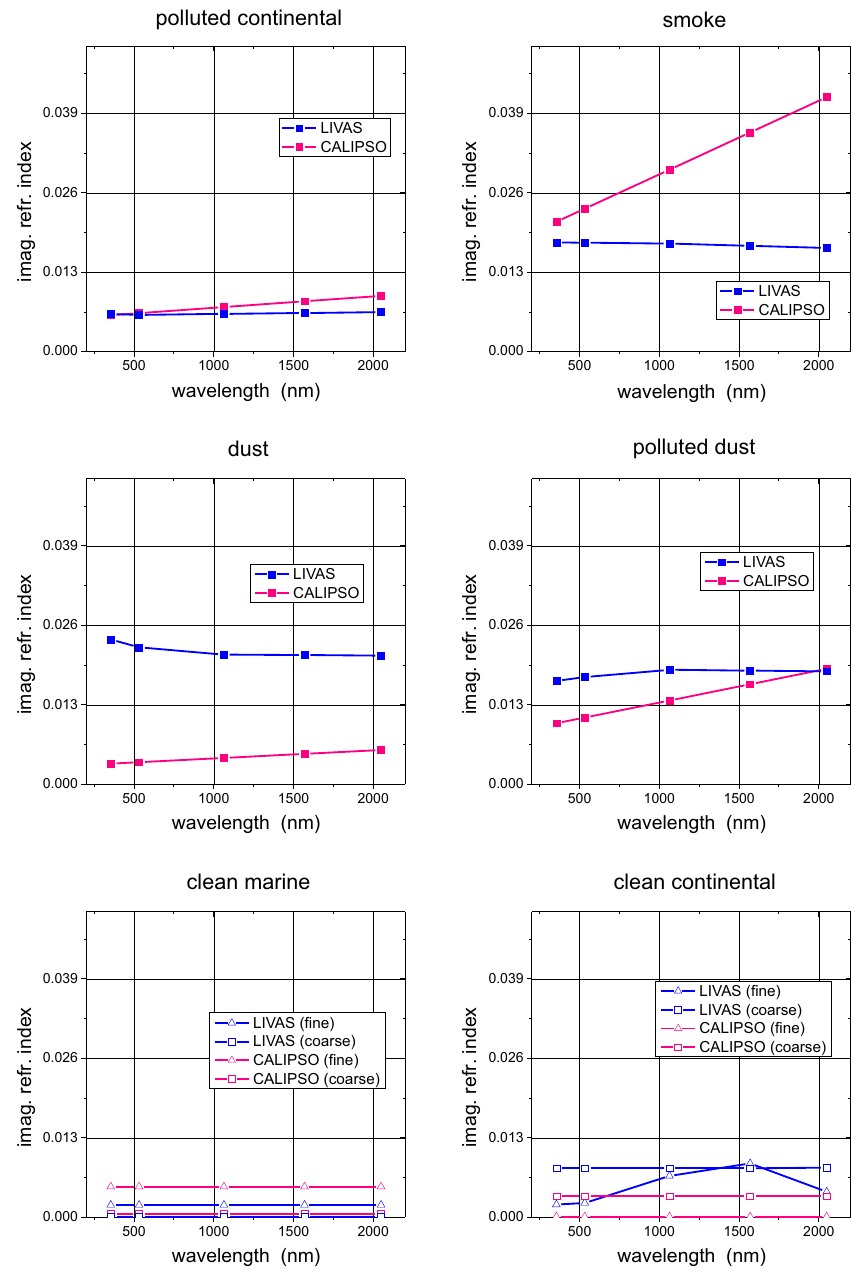
Figure 5. Comparison of the mean imaginary part of the refractive index for each aerosol type in the LIVAS (blue line) and CALIPSO (pink line) aerosol